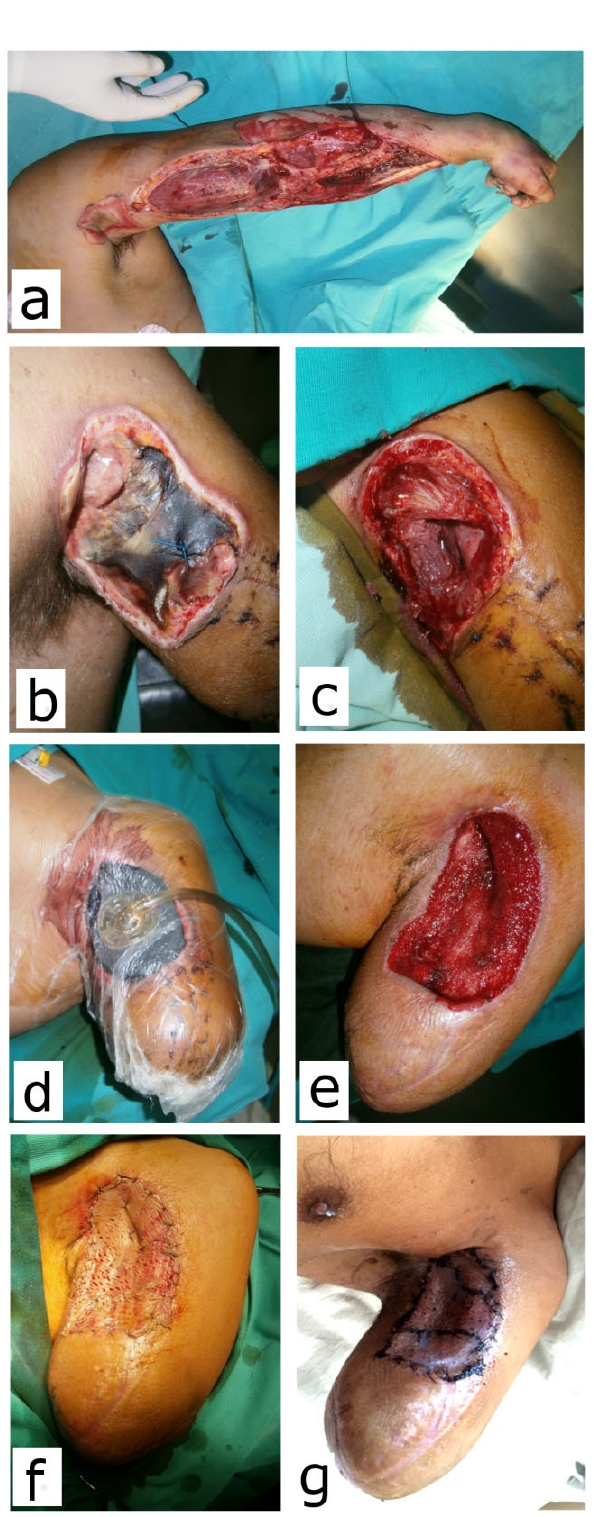
Figure 3. Arm amputation due to electrocution in a 16-year-old boy (Case 6). ( a ) Fasciotomy was performed immediately after injury; ( b ) Area of the coagulation necrosis on the base of the stump; ( c ) After debridement, 24 days post injury; ( d ) V.A.C. ® in place; ( e ) Granulation tissue after 3 weeks on V.A.C. ® ; ( f ) Wound covered with STSG; ( g ) Fourteen days after grafting, before referral to prosthetic treatment.